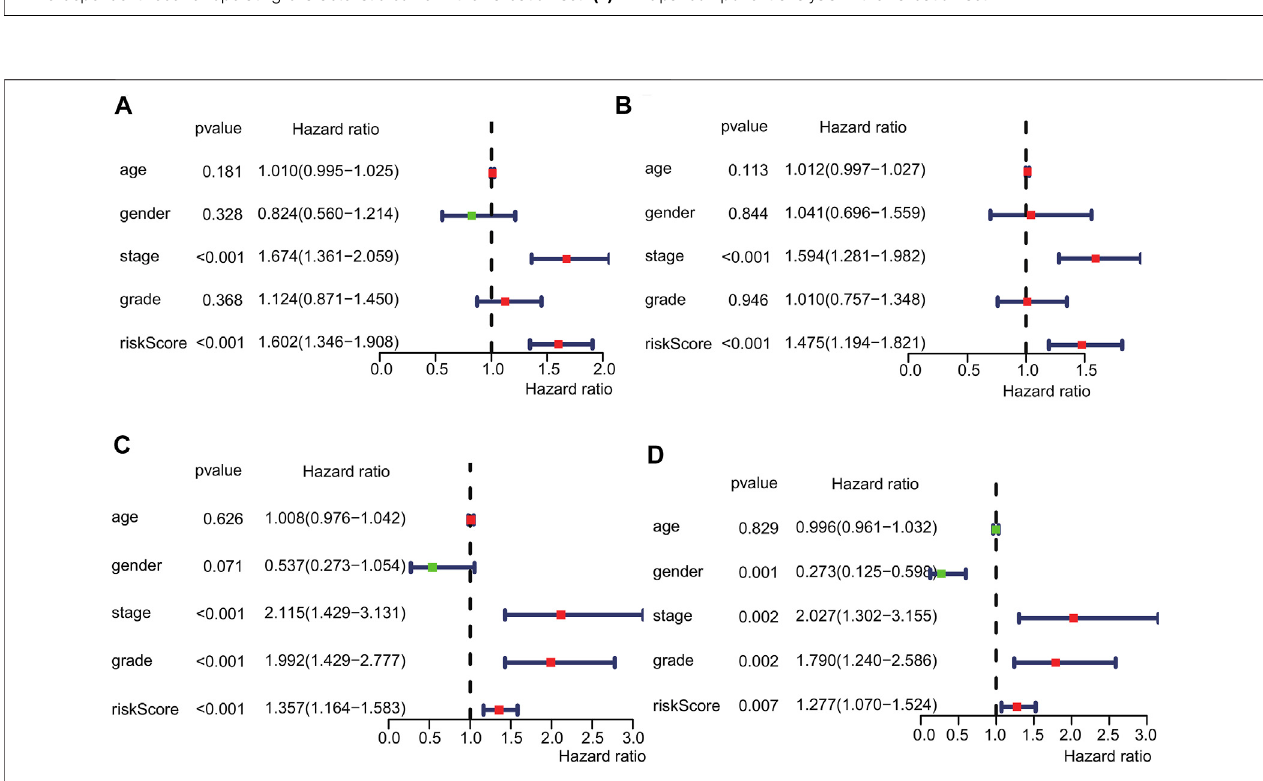
FIGURE 5 | Risk score as an independent prognostic factor. Univariate (A) and multivariate (B) Cox regression analyses in the training set. Univariate (C) and multivariate (D) Cox regression analyses in the validation set.